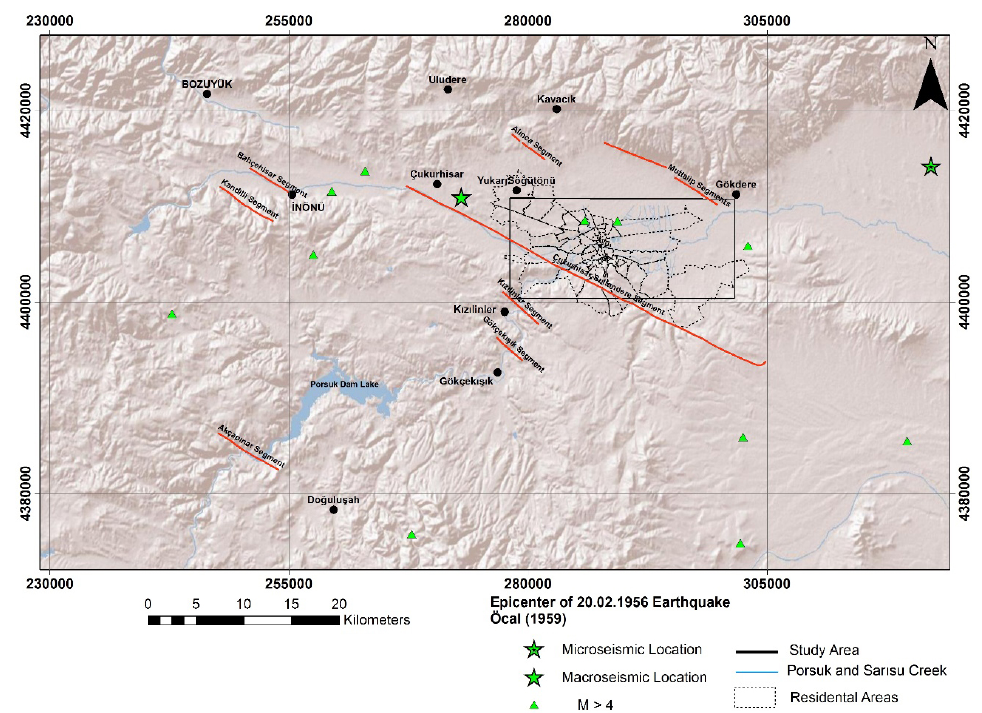
Figure 5. Seismotectonics of the study area (simplified from Seyito˘glu et al.,